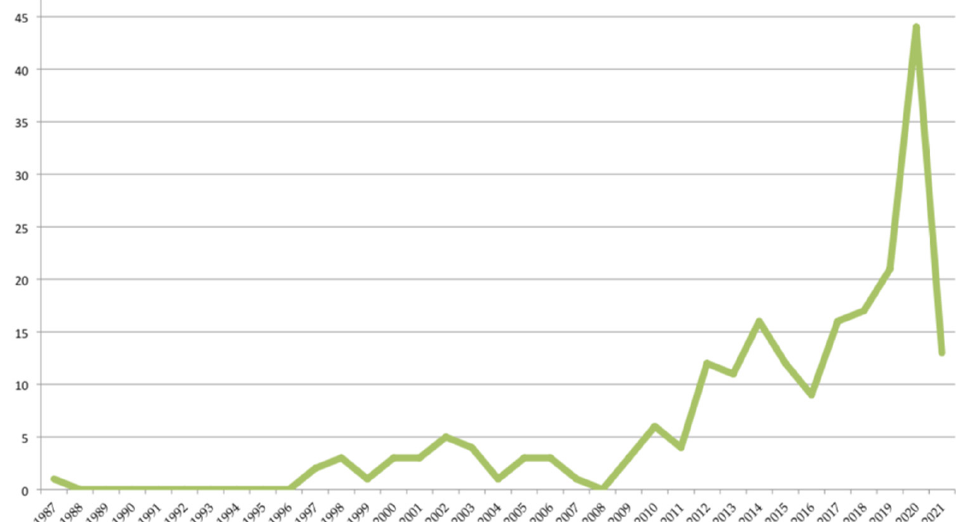
Figure 3. Number of documents per year of publication.